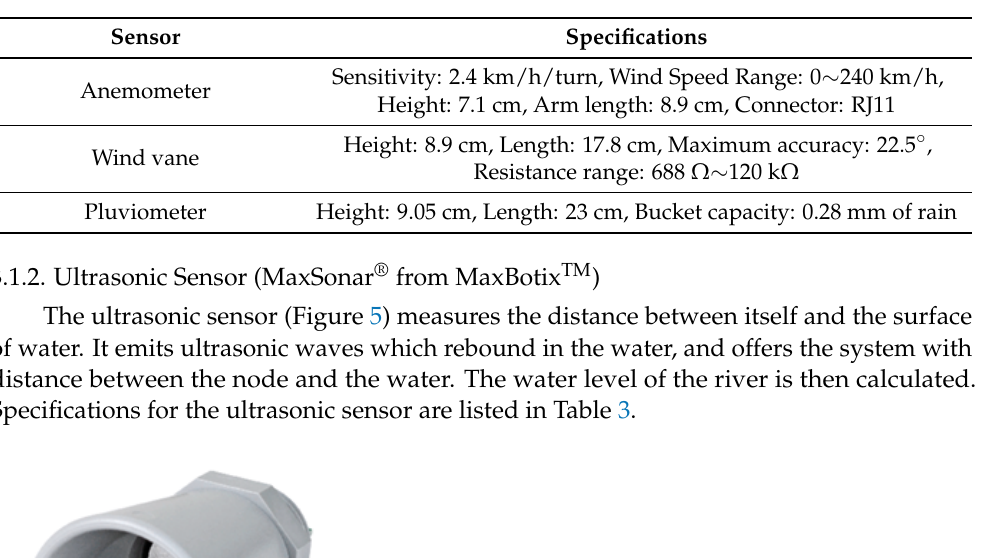
Table 2. Weather station sensor specifications.